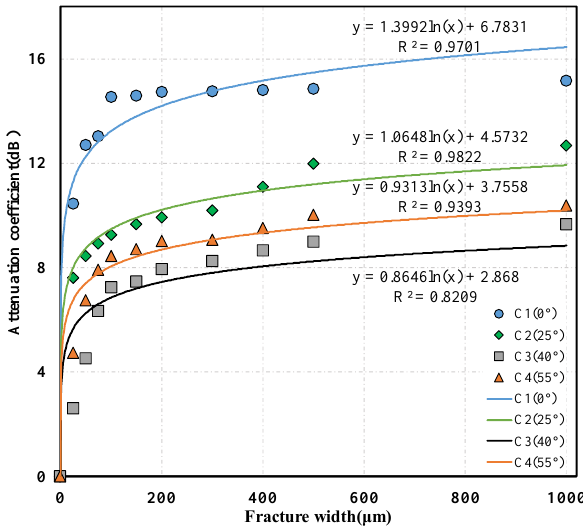
Figure 12. Relationship between shear wave attenuation coefficient and fracture width of the set of C cores containing fractures with different dip angles.